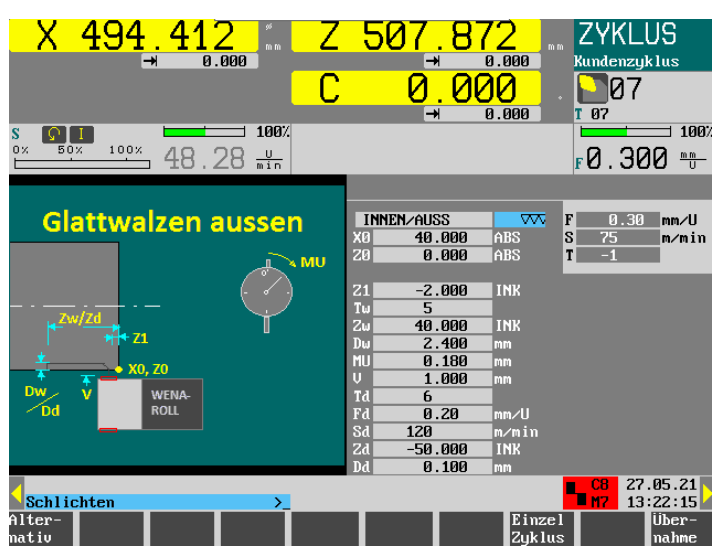
Figure 3. Roller burnishing cycle mask (German edition). Source: R&D Steuerungstechnik GmbH & Co.KG.